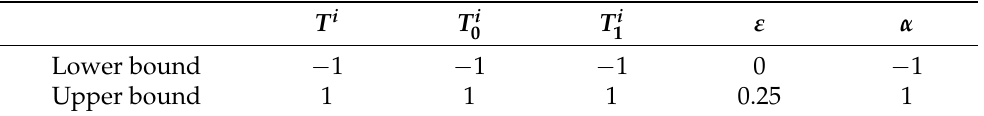
Table 1. Range of design